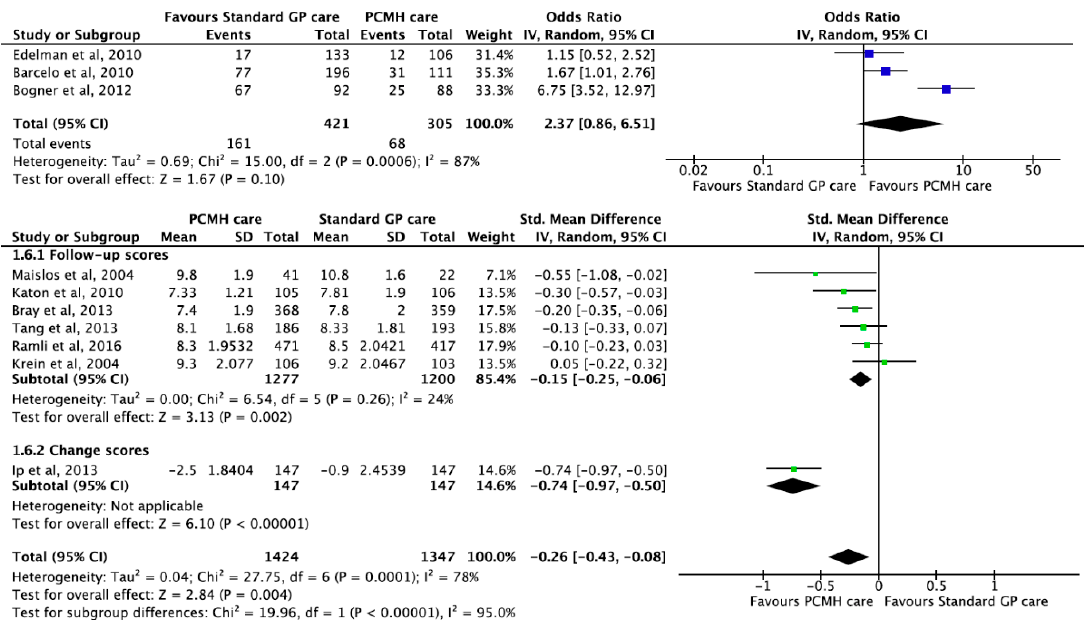
Figure 6. Forest plots of HbA1c outcomes between the PCMH care and Standard GP care. HbA1c control refers to HbA1c levels within the guideline’s recommended range.